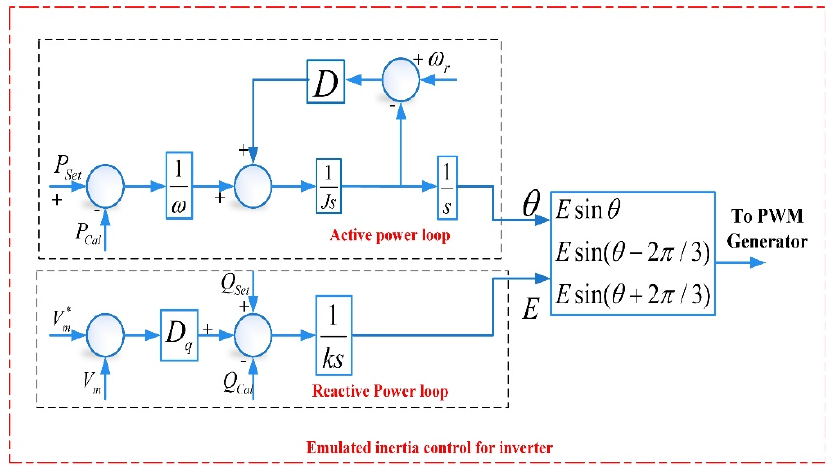
Figure 5. Conventional emulated inertia control.